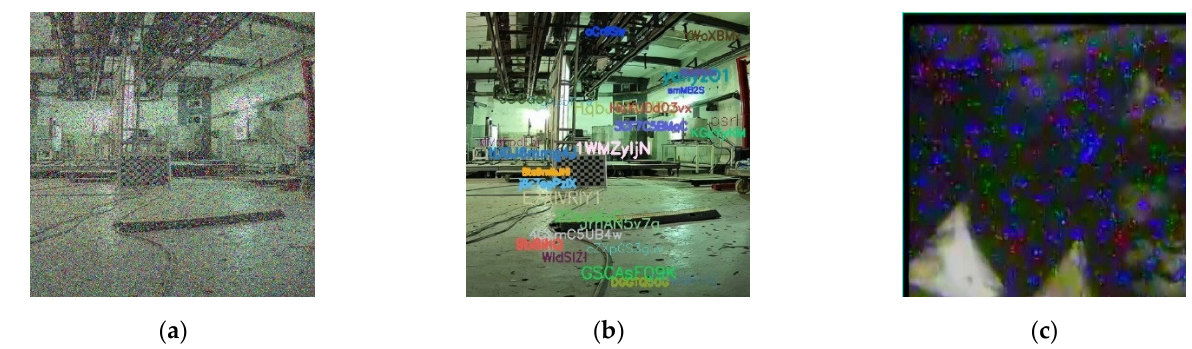
Figure 10. Visualization of different noise types. ( a , b ) Are synthetic impulse noise and text noise with the variance of 50 and 25, respectively; ( c ) is the real noise in our nuclear radiation dataset.